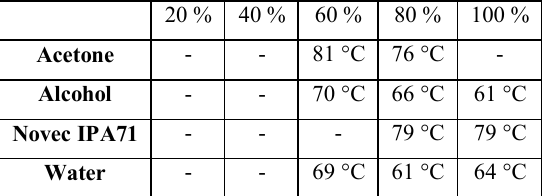
Table 2. Temperature in the electrotechnical box,